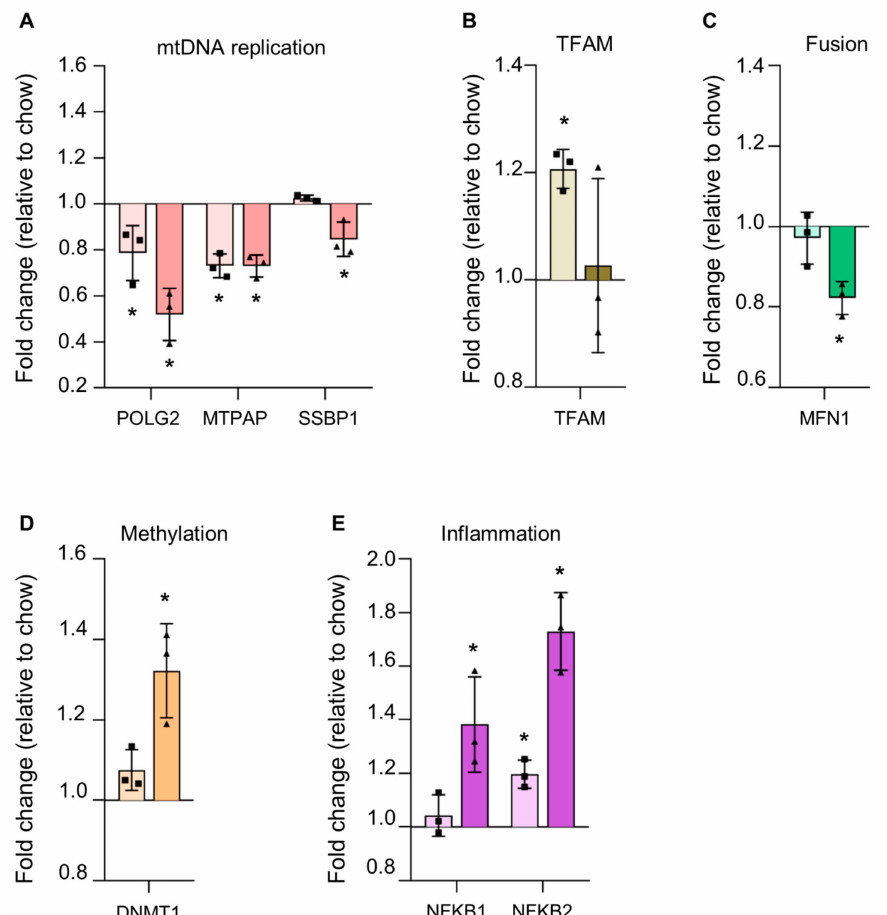
Figure 5. Changes to mtDNA replication, DNA methylation, and inflammation systems in steatotic liver. Altered levels of proteins involved in ( A ) mtDNA replication, ( B ) mtDNA packaging and transcription [mitochondrial transcription factor A (TFAM), ( C ) mitochondrial fusion dynamics, ( D ) nuclear genomic DNA methylation, and ( E ) inflammatory response pathways are seen in steatotic livers of mice fed with high fat (light bars) or Western (dark bars) diets. Fold change in protein level relative to chow diet fed mice is shown with bars for mean ± standard deviation. * p < 0.05 as determined by unpaired student t-test versus chow